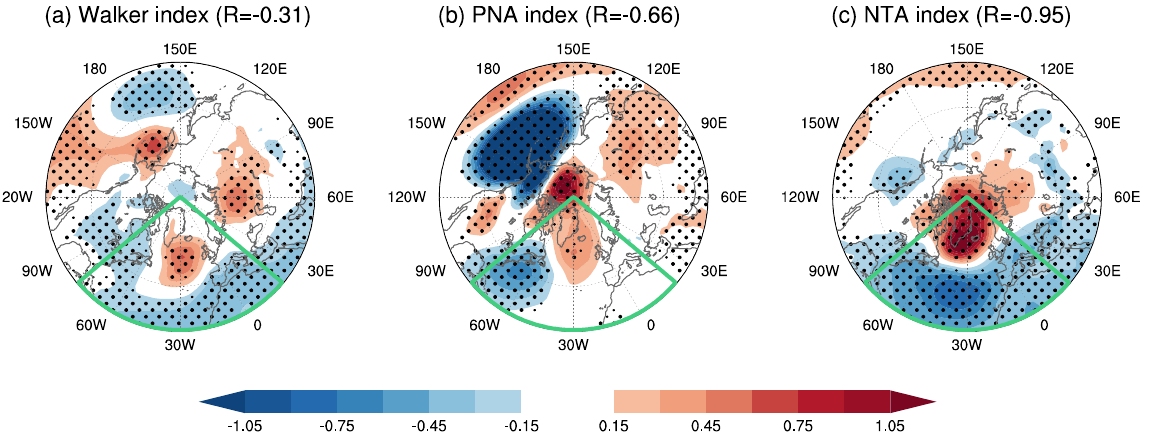
Figure 6. Monthly SLP anomalies (hPa) regressed upon the simultaneous ( a ) Walker index, ( b ) PNA index, and ( c ) NTA index. Dots indicate regression coefficients that are statistically significant at the 95% confidence level. The green box indicates the North Atlantic region (20°–90° N, 0°–80° W).